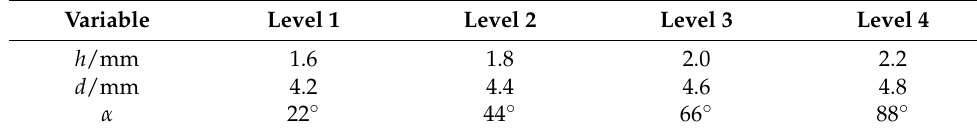
Table 2. Parameters level of the TRM structure.